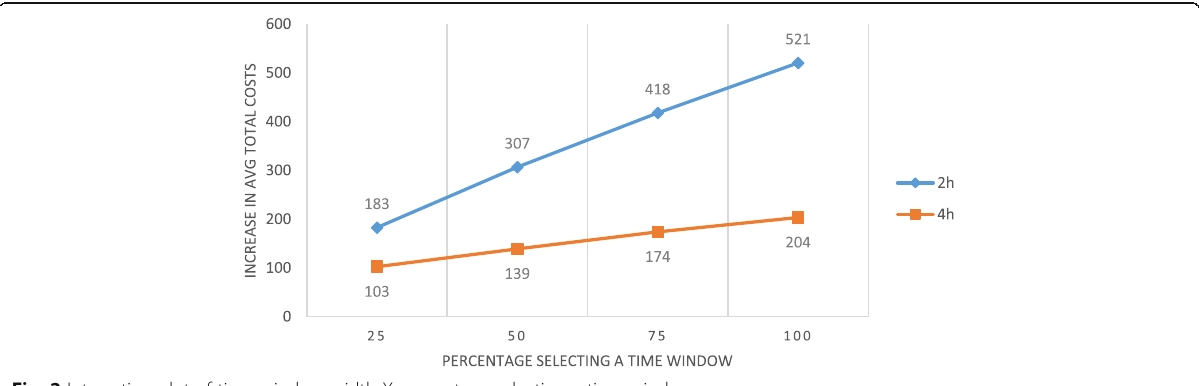
Fig. 2 Interaction plot of time window width X percentage selecting a time window